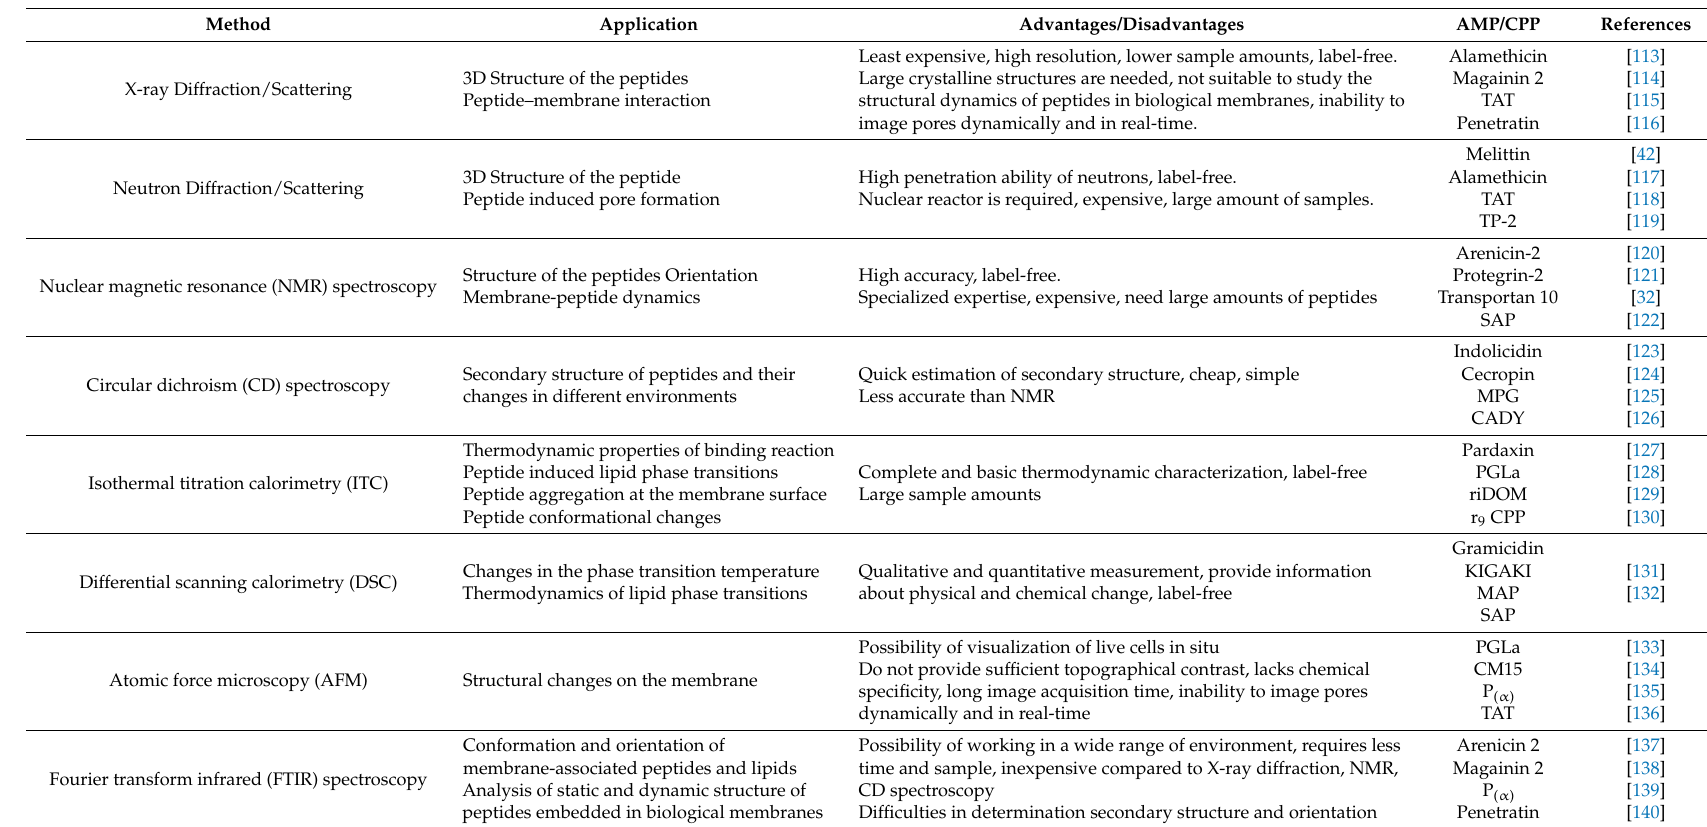
Table 1. Commonly used biophysical techniques for the study of membrane active